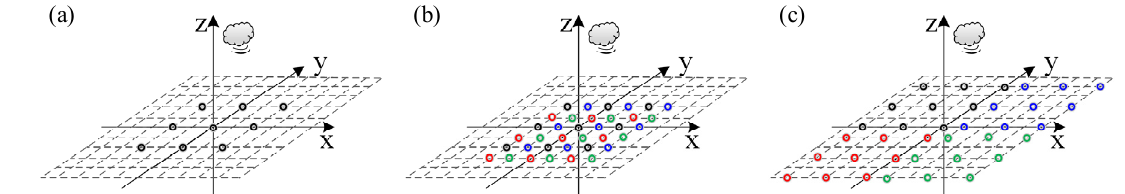
Figure 2. Schematic diagram of the non-synchronous measurements in a 2D space: ( a ) measurement with a planar microphone array; ( b ) non- synchronous measurements’ microphone array for a denser array; ( c ) non- synchronous measurements’ microphone array for a bigger array. The circle “ ○ ” represents a microphone, and the same color represents the microphones in the same test.